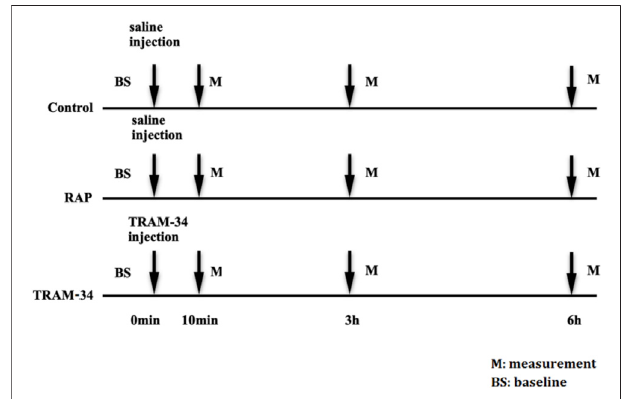
FIGURE 1 | Experimental fl ow chart. Abbreviations: BS, baseline; RAP, rapid atrium pacing; M,